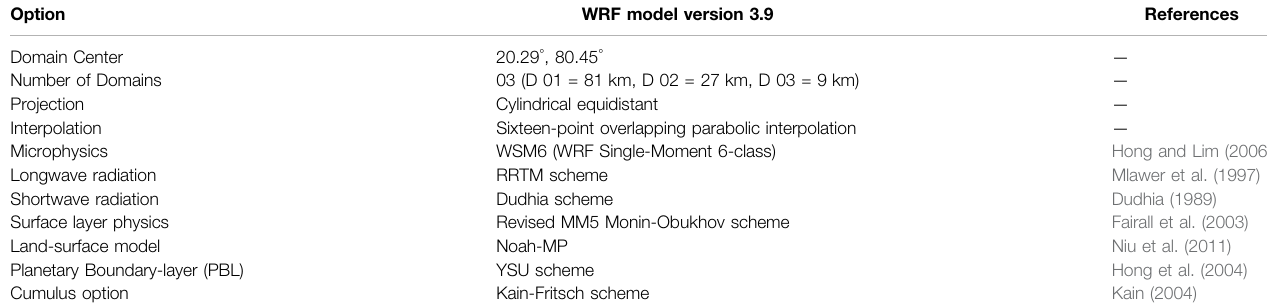
TABLE 2 | Model con fi guration used for WRF simulation.